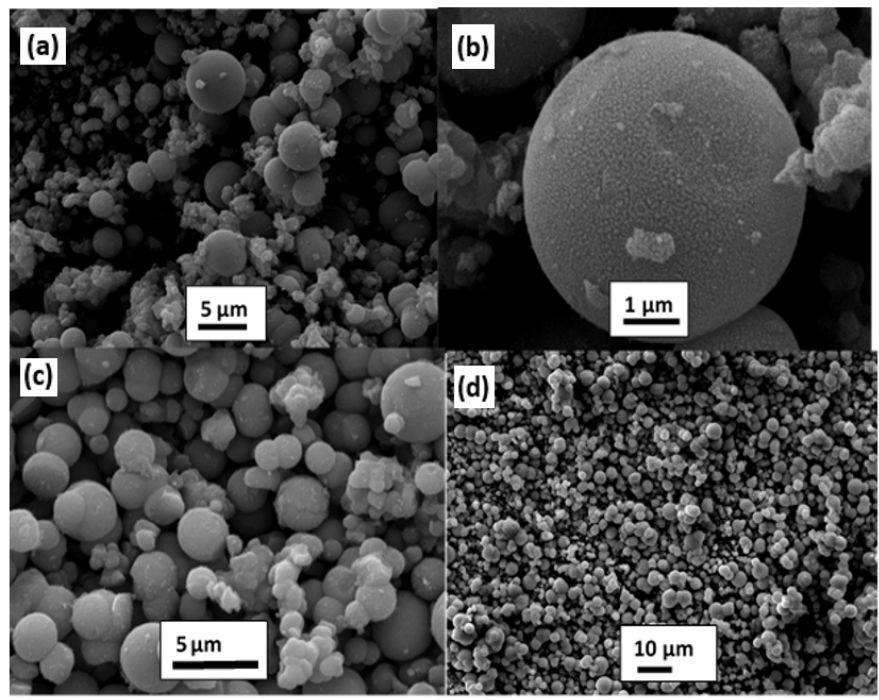
Figure 13. SEM images of ( a , b ) TiO 2 , ( c ) Fe-TiO 2 (0.025 wt%), and ( d ) Fe/TiO 2 (1 wt%). Reprinted from [35].